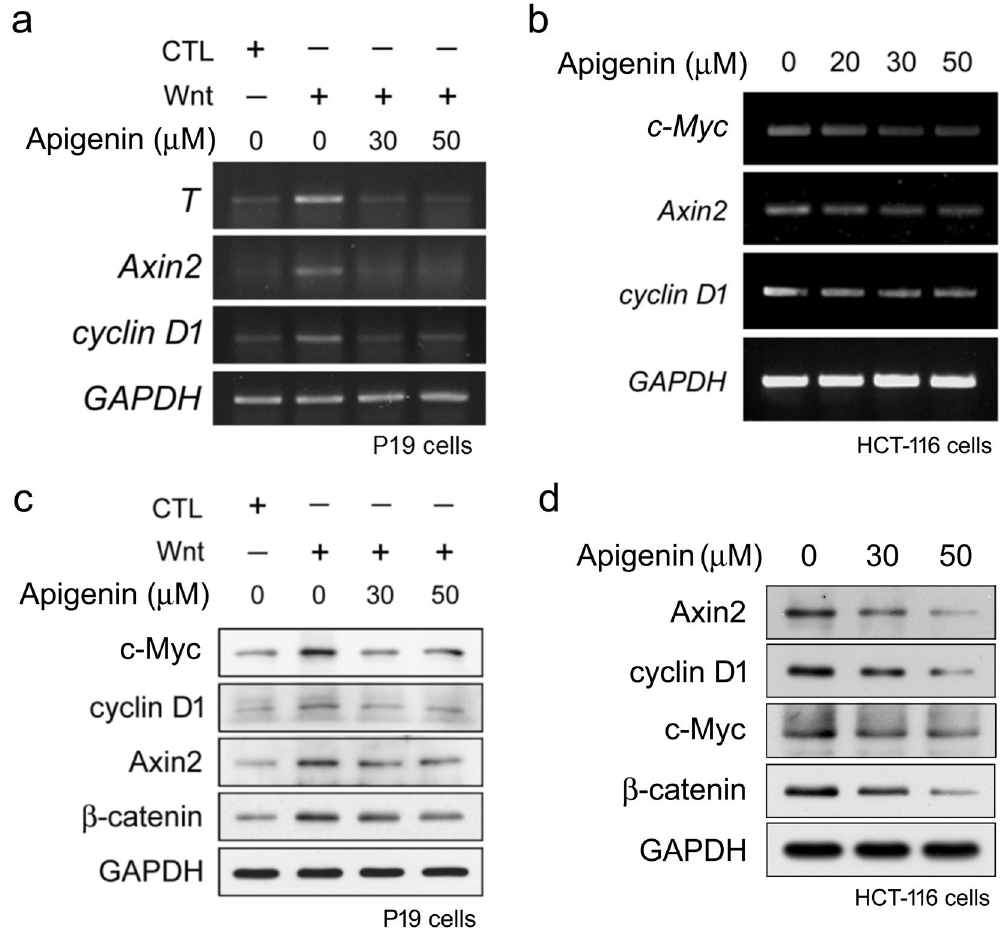
Figure 2. Apigenin suppresses the expression of Wnt target genes. ( a ) Apigenin inhibits the mRNA expression of Wnt target genes in Wnt-stimulated P19 cells. Cells were treated with control-conditioned medium, Wnt-3a- conditioned medium, or different concentrations (30, 50 μ M) of apigenin in Wnt-3a-conditioned medium for 16 h, and then cells were collected for RT-PCR analyses using gene-specific primers for T , Axin2 , cyclin D1 , and GAPDH (used as the internal control) as described in methods. ( b ) Apigenin represses the mRNA expression of Wnt target genes in HCT-116 cells. Cells were treated with different concentrations (0, 20, 30, 50 μ M) of apigenin for 22 h and total RNAs were isolated. cDNAs were then synthesized and used for amplification of the specified genes using gene-specific primers for c - Myc , Axin2 , cyclin D1 , and GAPDH . ( c ) Apigenin inhibits the protein expression of Wnt target genes in Wnt-stimulated P19 cells. Cells were treated with control-conditioned medium, Wnt-3a-conditioned medium, or different concentrations (30, 50 μ M) of apigenin in Wnt-3a- conditioned medium for 16 h, and then cells were collected for Western blotting analyses with anti-c-Myc, anti-cyclin D1, anti-Axin2, anti-beta-catenin, and anti-GAPDH (as the loading control). ( d ) Apigenin inhibits the protein expression of Wnt target genes in HCT-116 colorectal cancer cells. Cells were treated with different concentrations (0, 30, 50 μ M) of apigenin for 22 h and total cell lysates were isolated for Western blotting analyses with anti-Axin2, anti-cyclin D1, anti-c-Myc, anti- β -catenin, and